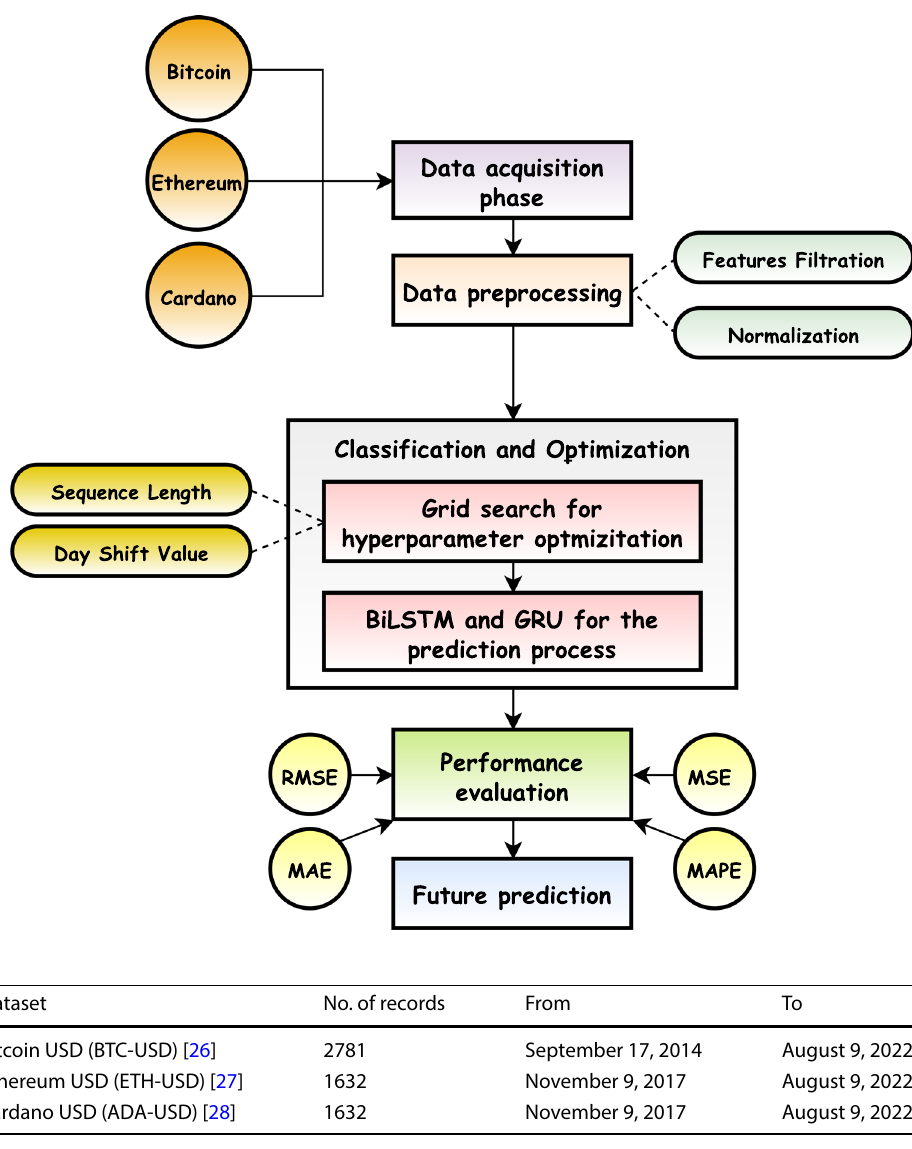
Fig. 3 The suggested frame- work for the cryptocurrency price prediction